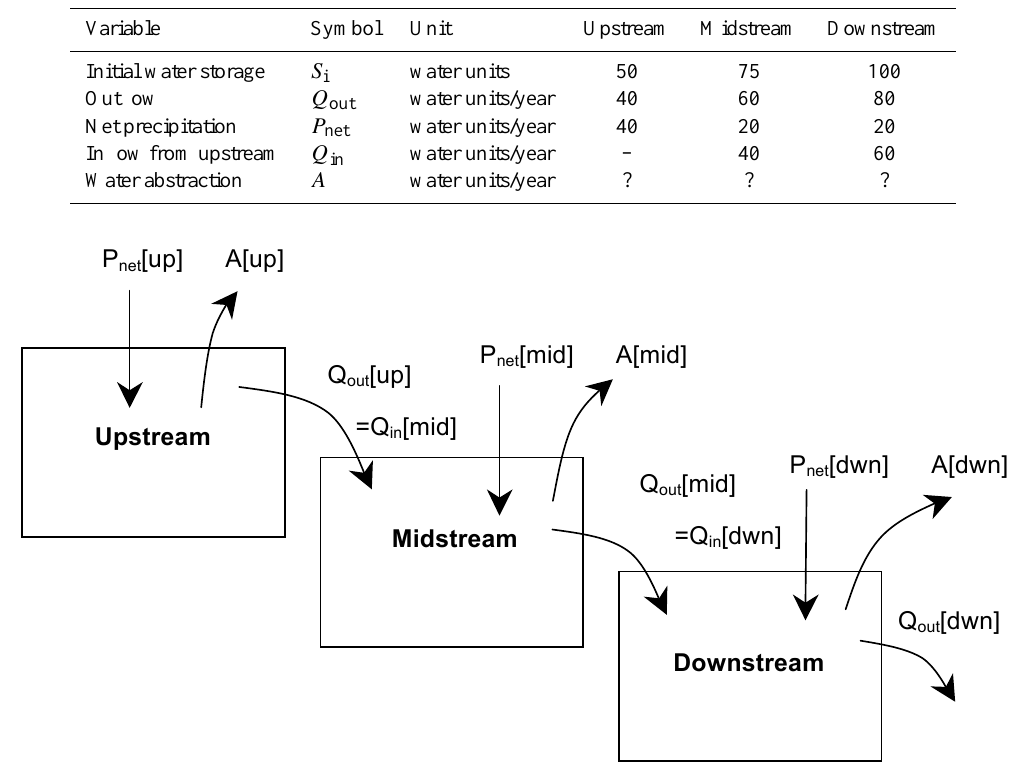
Fig. 1. The river basin schematisation in the River Basin Game.